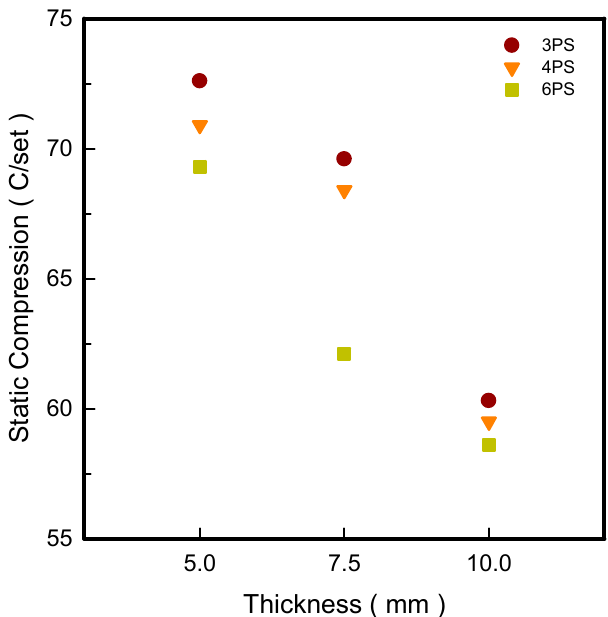
Figure 2. Static compression for the LW 3DP 3-, 4-, and 6-SP outsole specimens with various thick- nesses.